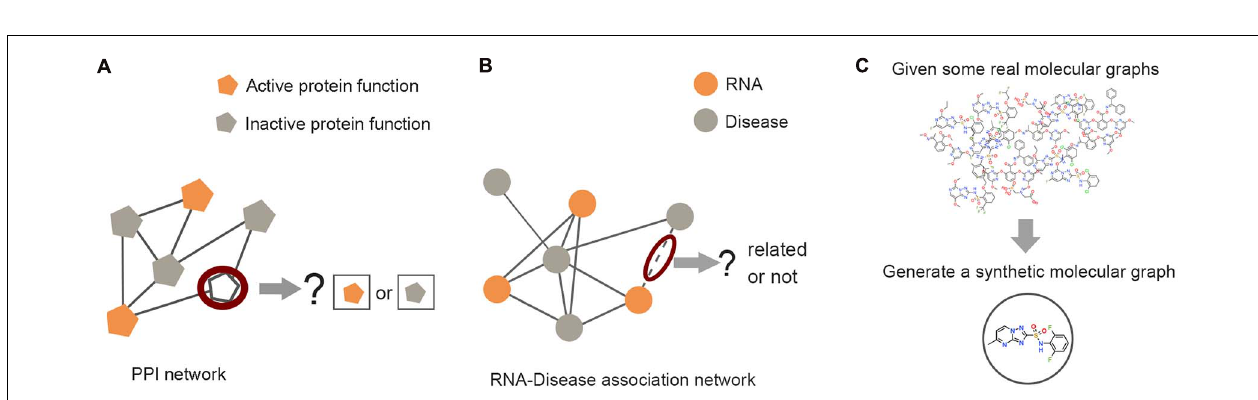
FIGURE 4 | Two modeling methods of biological data with graph structure. (A) Molecular structure-based modeling. (B) Biological network-based modeling.